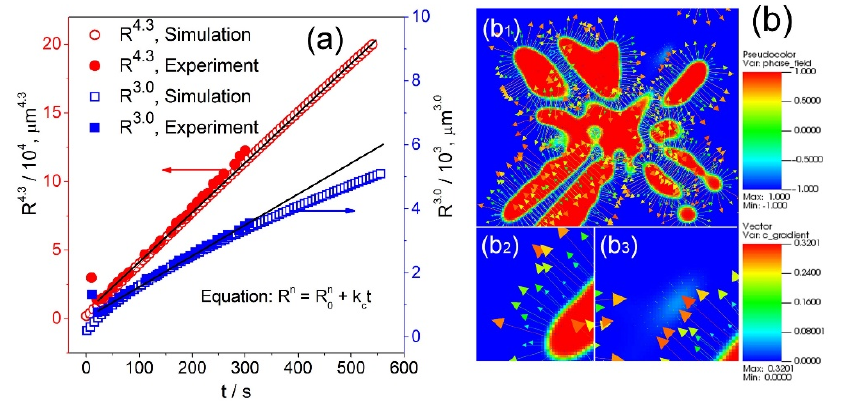
= k c ( t − t ) , ( b ) the 0 0